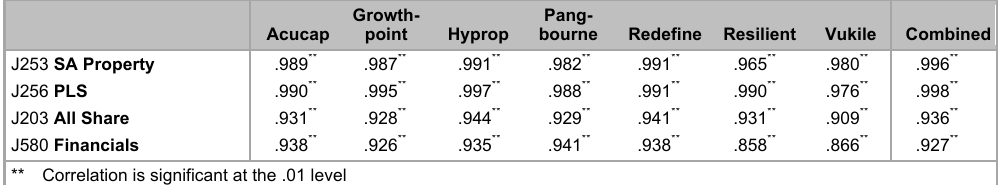
JSE indices correlation to weighted average share prices of PLSs Growth- Pang- Acucap point Hyprop